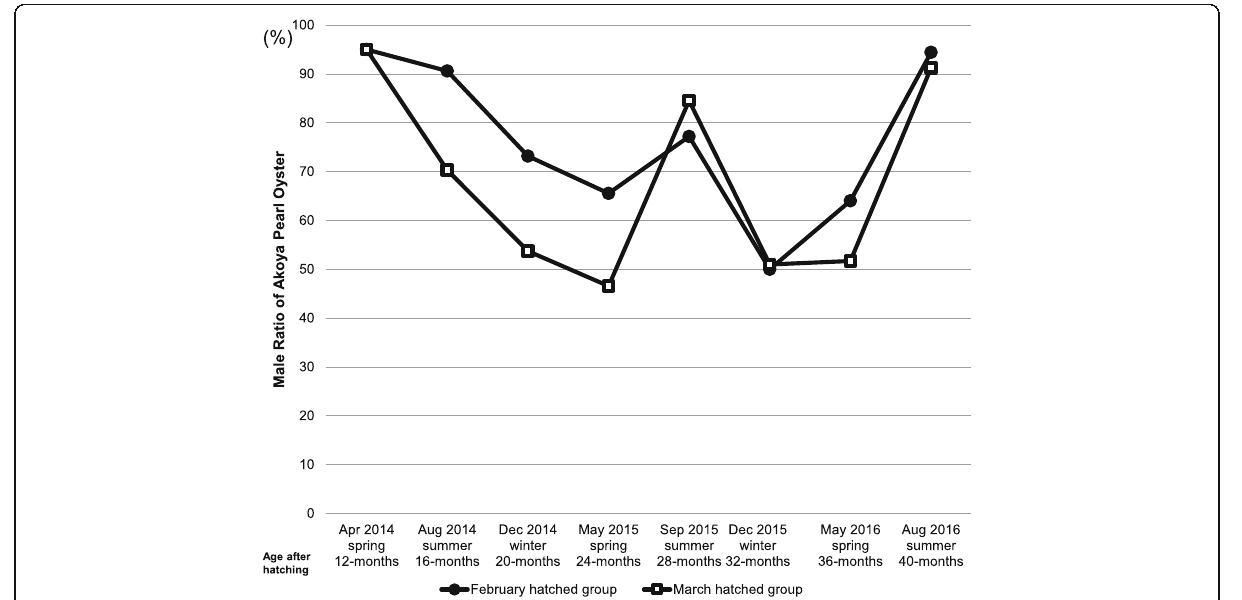
Fig. 1 Male ratio of Akoya pearl oyster (P. fucata) at seven sampling times. The sex of individual Akoya pearl oysters in two different hatching groups were determined every four months by biopsy. Male ratio was calculated based on the sex obtained from biopsy